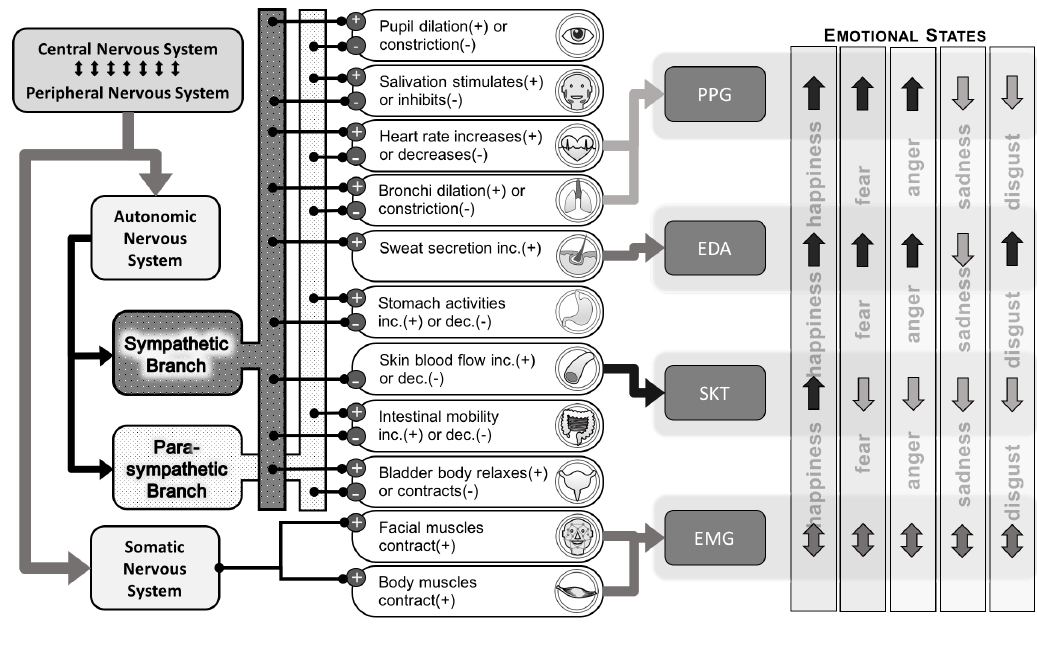
Figure 1. Simplified emotion recognition using common wearable biosensors. SKT, skin